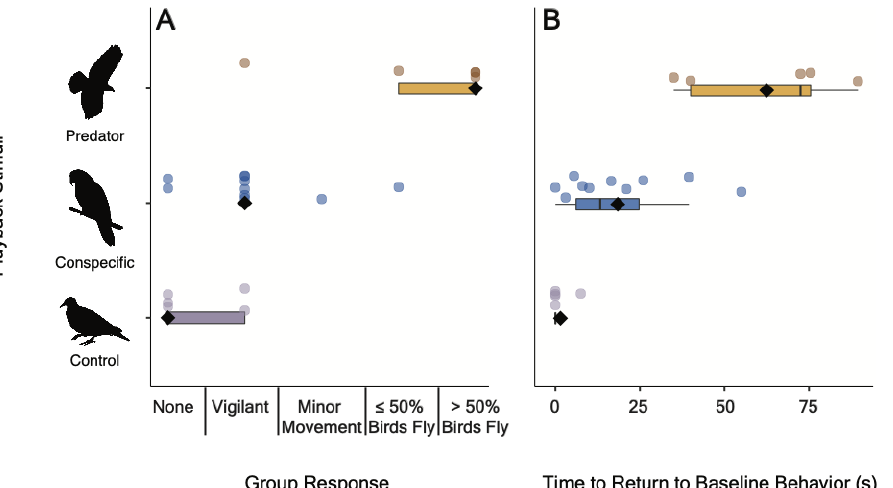
Monk Parakeets’ Behavioral Responses to Playback